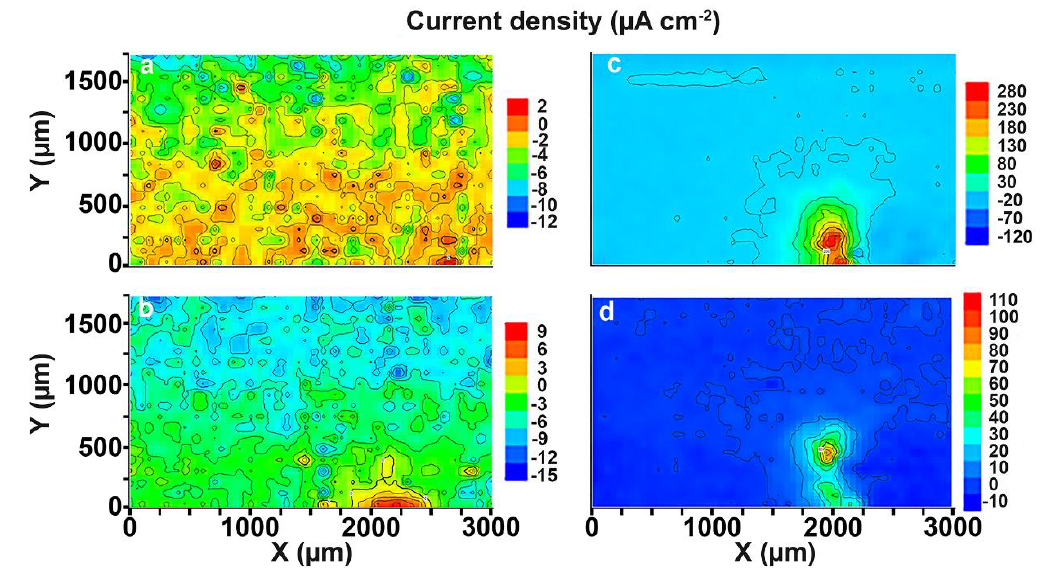
Figure 8. SVET diagrams of the current density values distribution on the surface of the welded joint area of the 1579 aluminium alloy sample after ( a ) 1.5, ( b ) 4.5, ( c ) 81, and ( d ) 87 h of immersion in 0.5 M NaCl. There is an anodic zone at the right bottom part of the investigated area.